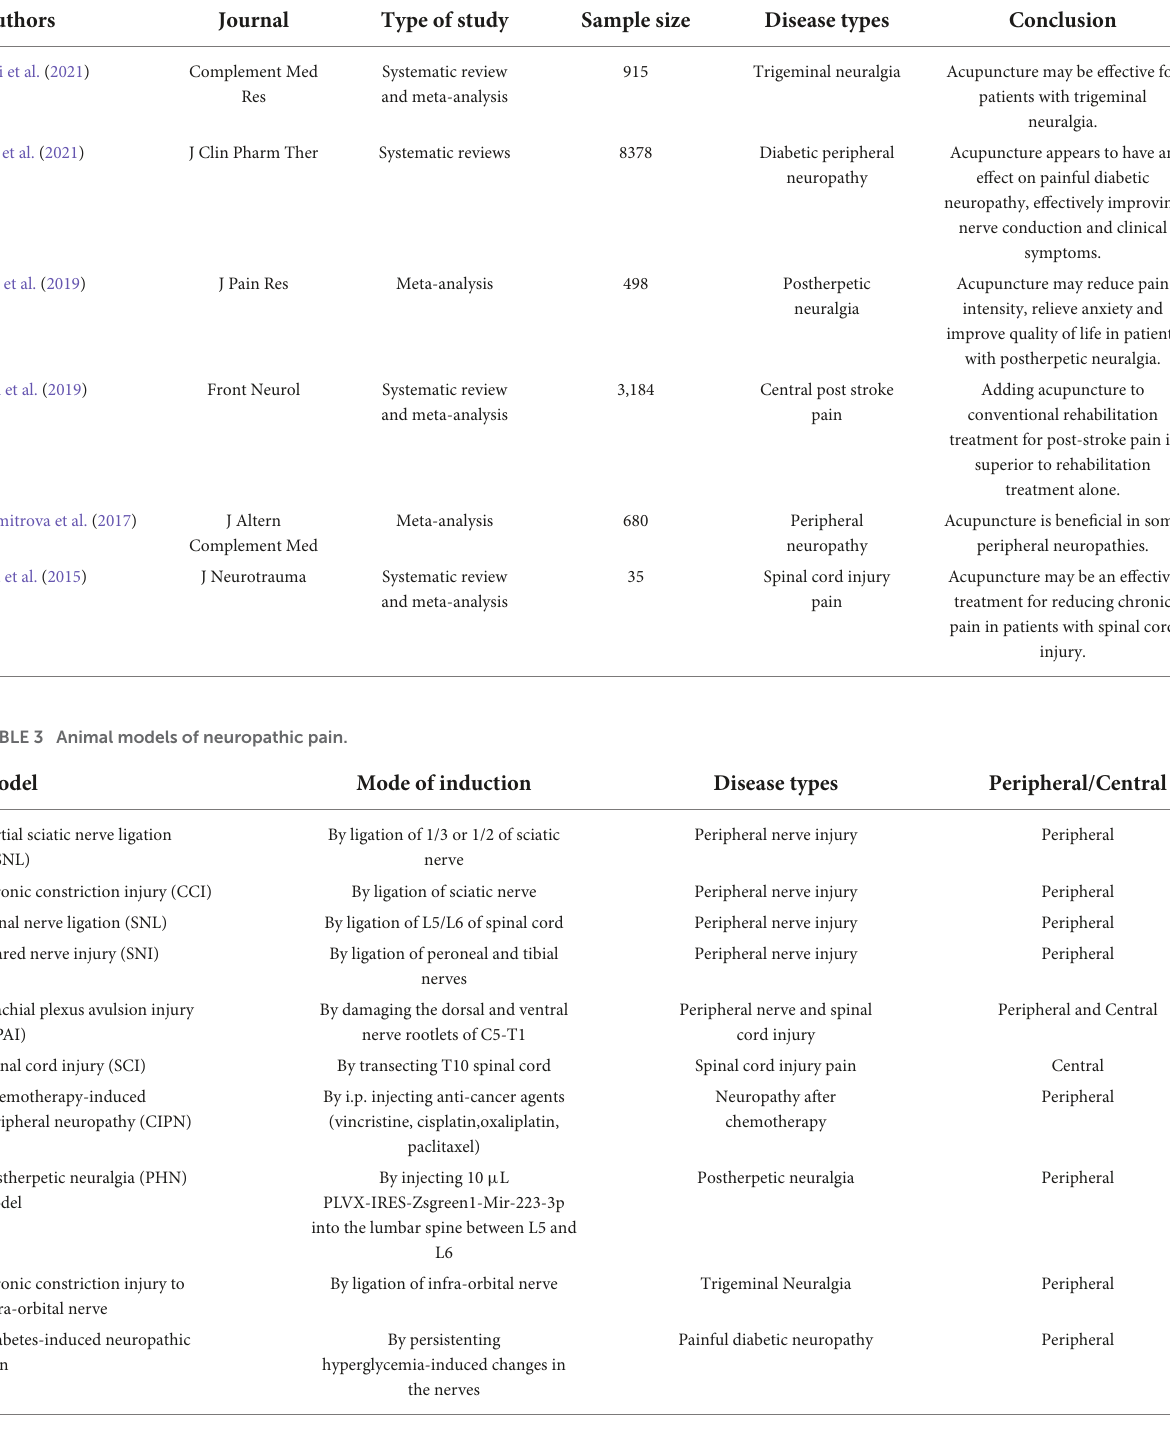
TABLE 2 Efficacy of acupuncture for neuropathic pain.